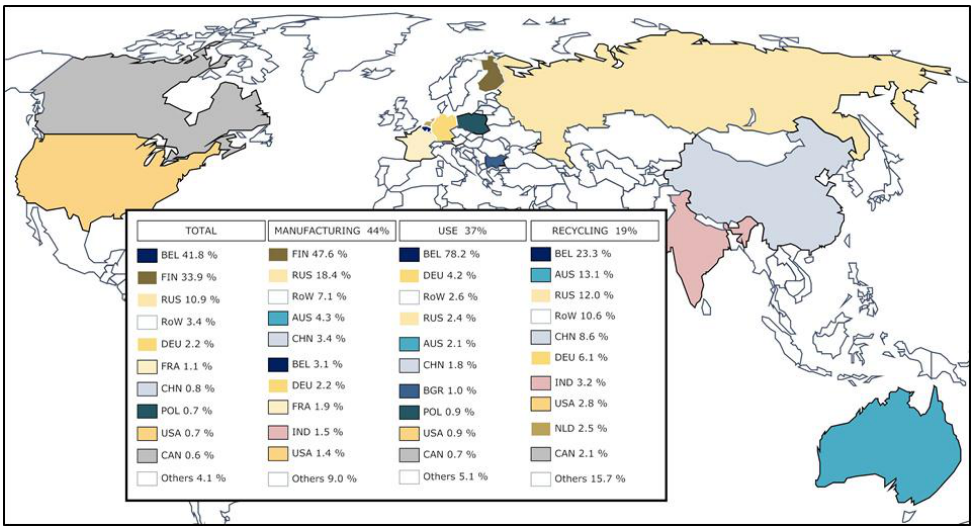
Figure 7. Geographical resolution and country contribution to Global Warming Potential. Table 1. Contribution of the top 3 countries and regions to the total impacts of Terrestrial Acidification, Photochemical Ozone Formation and Particulate Matter Formation.